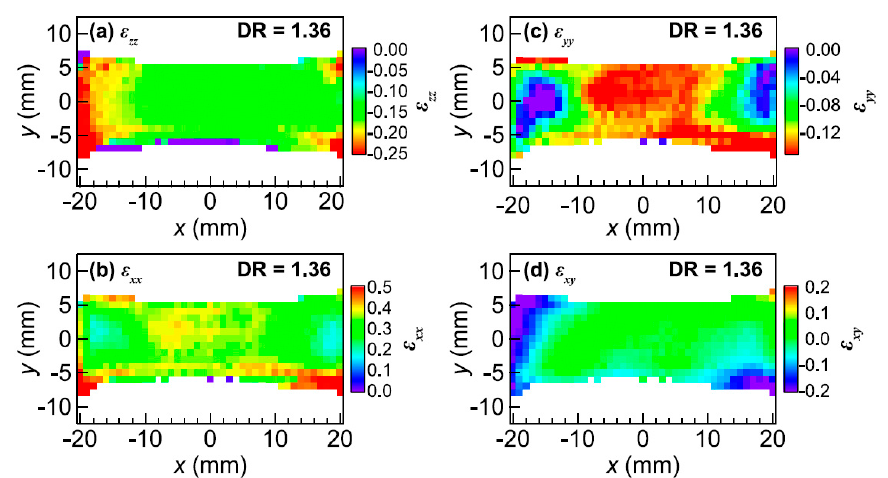
Figure 7. Spatial mapping of the four components of the strain tensor of a stretched black rubber sample evaluated by the PS THz-TDS measurements. ( a ) Strain tensor component ε zz ; ( b ) ε xx ; ( c ) ε yy ; and ( d ) ε xy . The draw ratio is 1.36. (Reprinted from reference [83] used in accordance with the Creative Commons Attribution (CC BY)